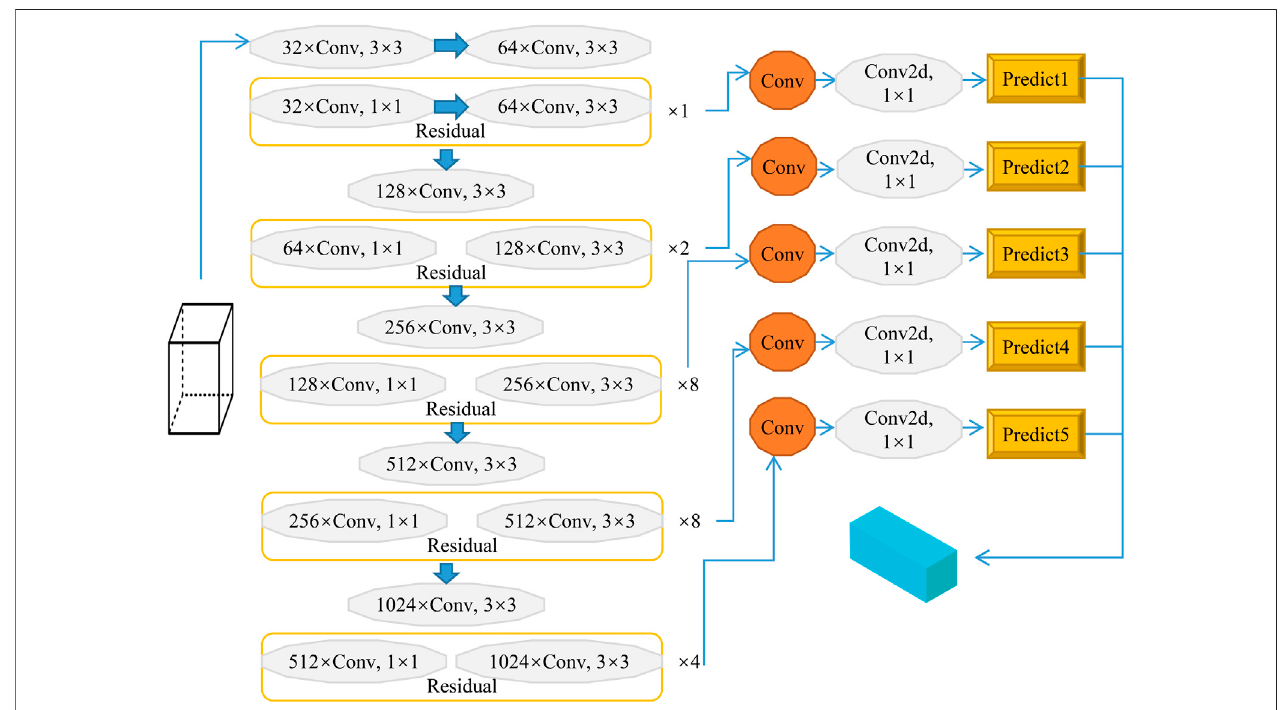
FIGURE 5 | Improved YOLO model for high spatial resolution biomimetic remote sensing target